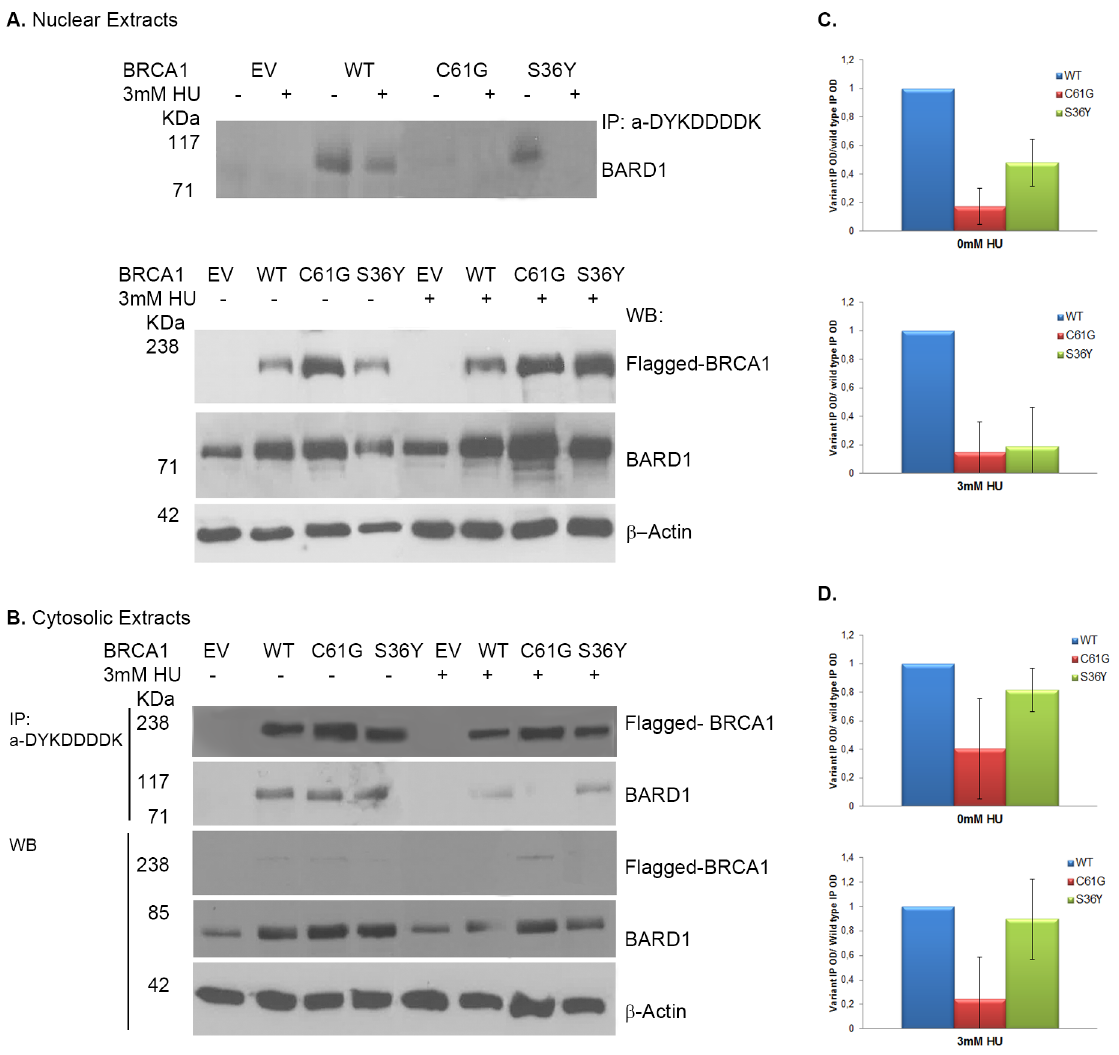
Figure 4. p.Ser36Tyr (S36Y) BRCA1:BARD1 complex is withheld within the cytoplasm following HU treatment. Lysates of transfected cells were fractionated into nuclear and cytosolic extracts following S-phase synchronization and treatment with HU. BARD1 was co-precipitated with the ectopically expressed BRCA1 in the A. Nuclear and B. Cytosolic extracts with the anti-DYKDDDDK tag antibody which recognizes only the exogenous BRCA1. A. Immunoblot analysis of the pull-downs demonstrated that unlike wild type BRCA1, both the p.Ser36Tyr and p.Cys61Gly (C61G) variants exhibit reduced ability to co-precipitate BARD1 in the nuclear extracts of stressed cells. B. However, in the cytosolic extracts the p.Ser36Tyr variant, but not p.Cys61Gly, co-precipitated a higher proportion of BARD1 in treated cells compared to wild type transfected cells. In untreated cells, both variants, including wild type BRCA1, co-precipitated larger amounts of BARD1 compared to treated cells. Bar charts showing that C. in the nuclei of treated cells, both the p.Ser36Tyr and p.Cys61Gly variants exhibit reduced ability to co-precipitate with BARD1, whereas D. in the cytosol the p.Ser36Tyr variant co-precipitates similar levels of BARD1 compared to wild type BRCA1, but it is not statistically significant. Immunoblot analysis of nuclear and cytoplasmic extracts demonstrating their purity is shown in Fig. S2. The results are representative of 2